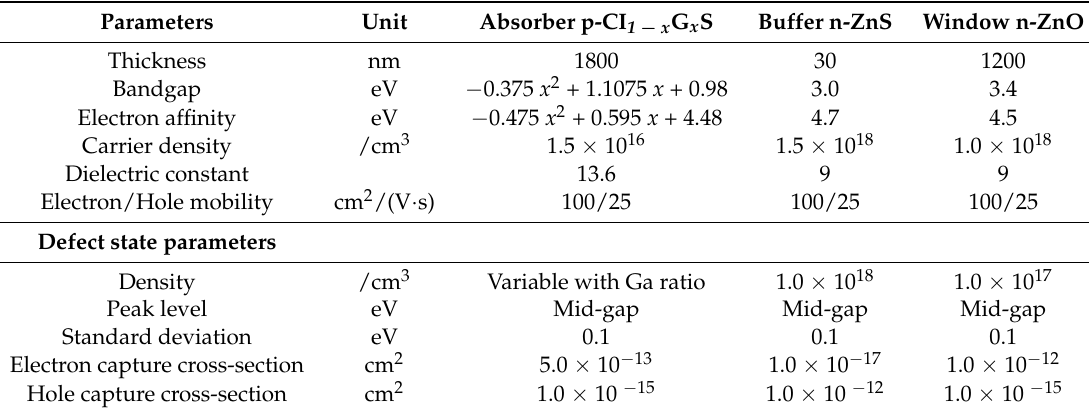
Table 1. Primary parameters of the materials in CIGS solar